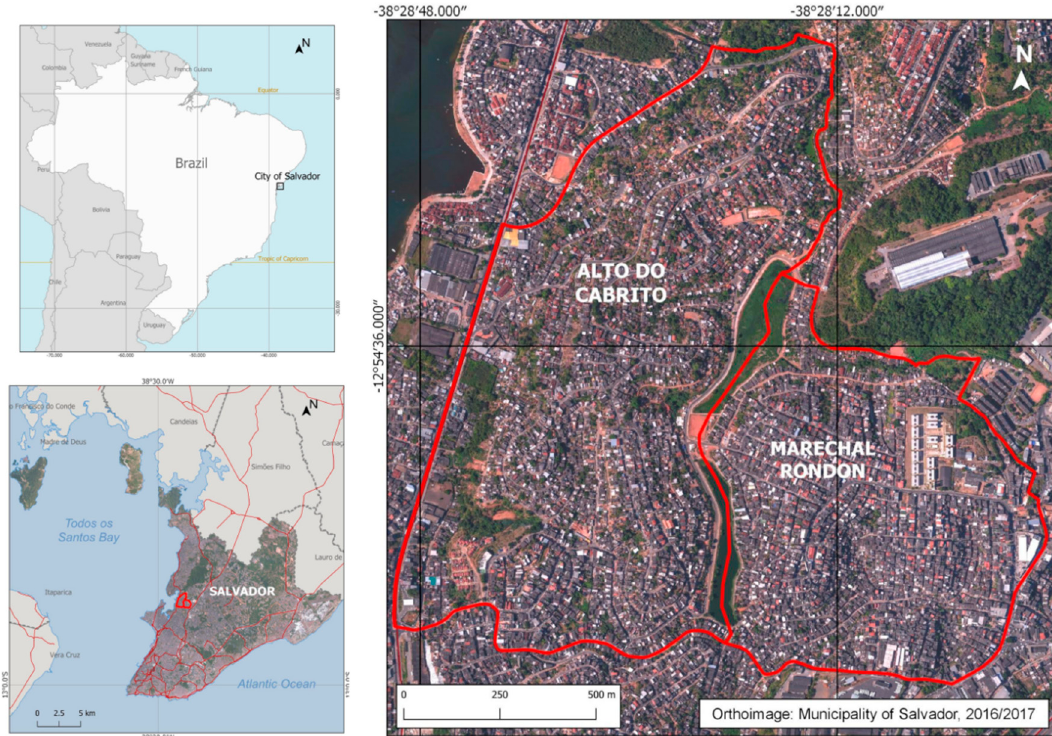
Figure 3. Overview of the case study area. Map of Alto do Cabrito and Marechal Rondon of Salvador City; Brazil (upper left); Salvador (lower left); case study neighborhoods (right). Produced by the authors. Data source: Brazilian Institute of Geography and Statistics (IBGE) and Municipality of Salvador.